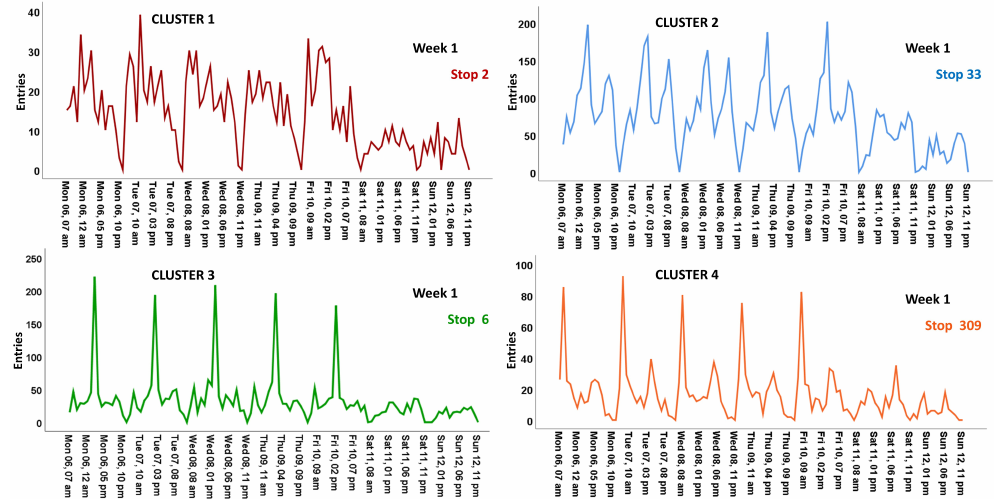
Figure 6. Representatives for each